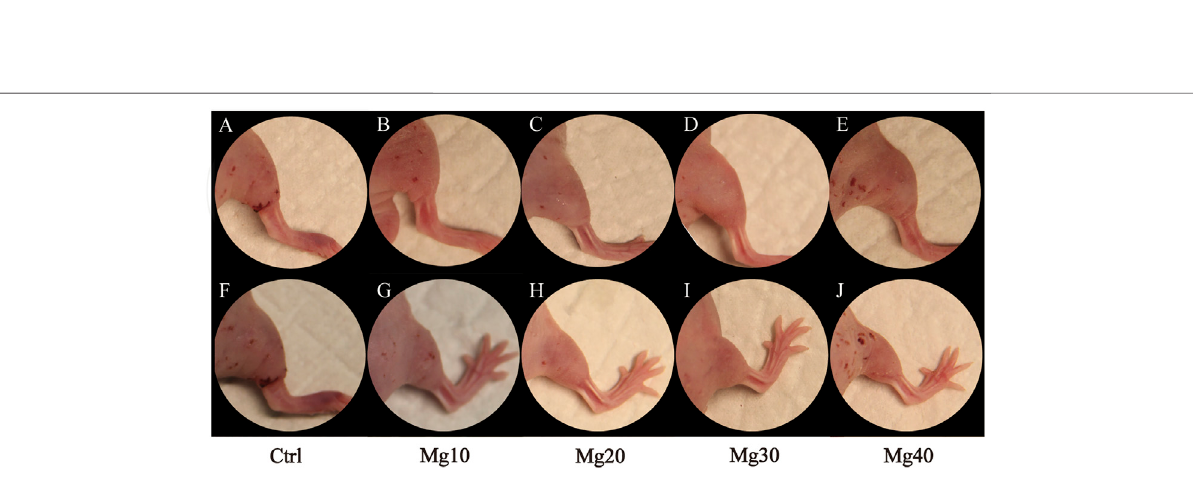
Frontiers in Bioengineering and Biotechnology |